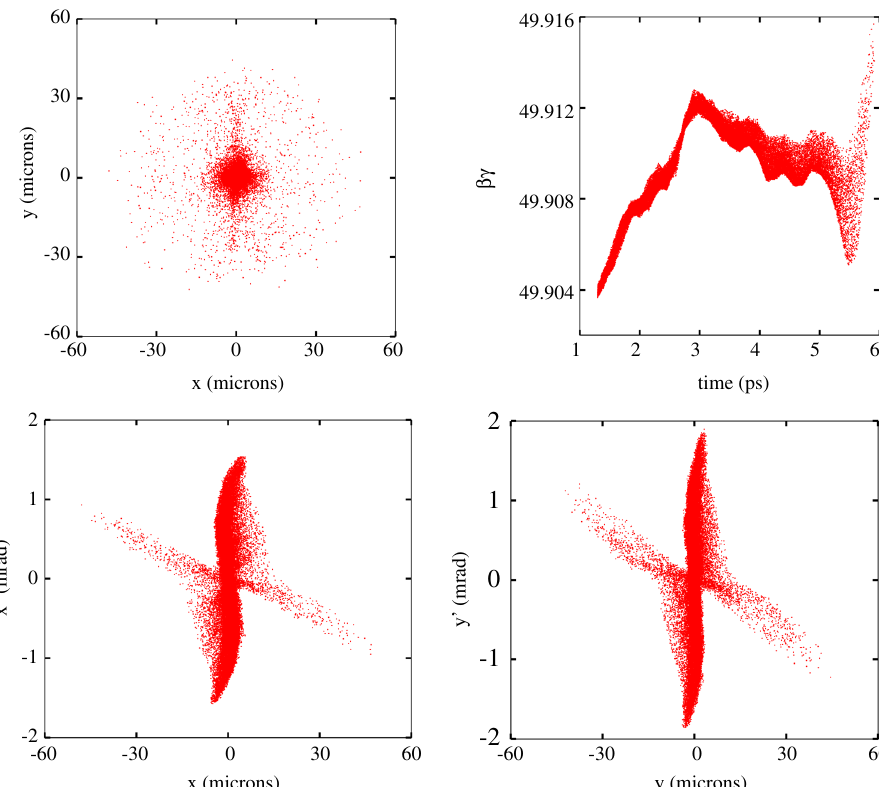
FIG. 11. The beam spot (upper left), longitudinal phase space (upper right), horizontal phase space (lower left), and vertical phase space (lower right) of the electron bunch at the collision point.